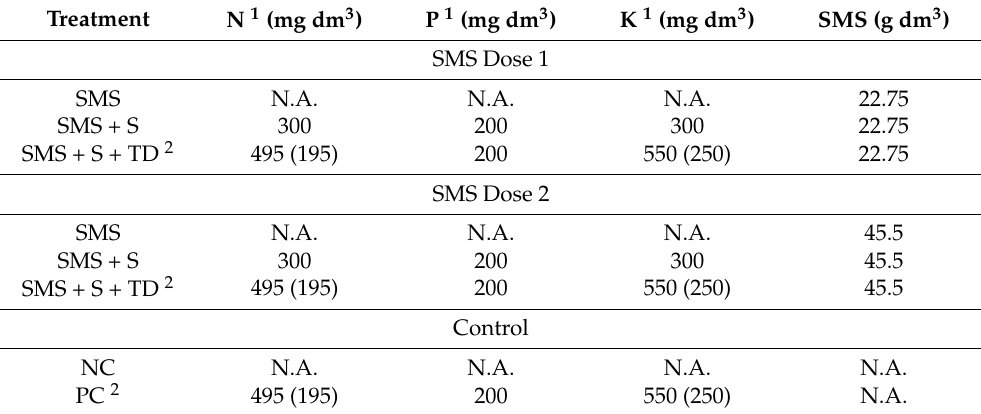
Table 1. Description of experimental